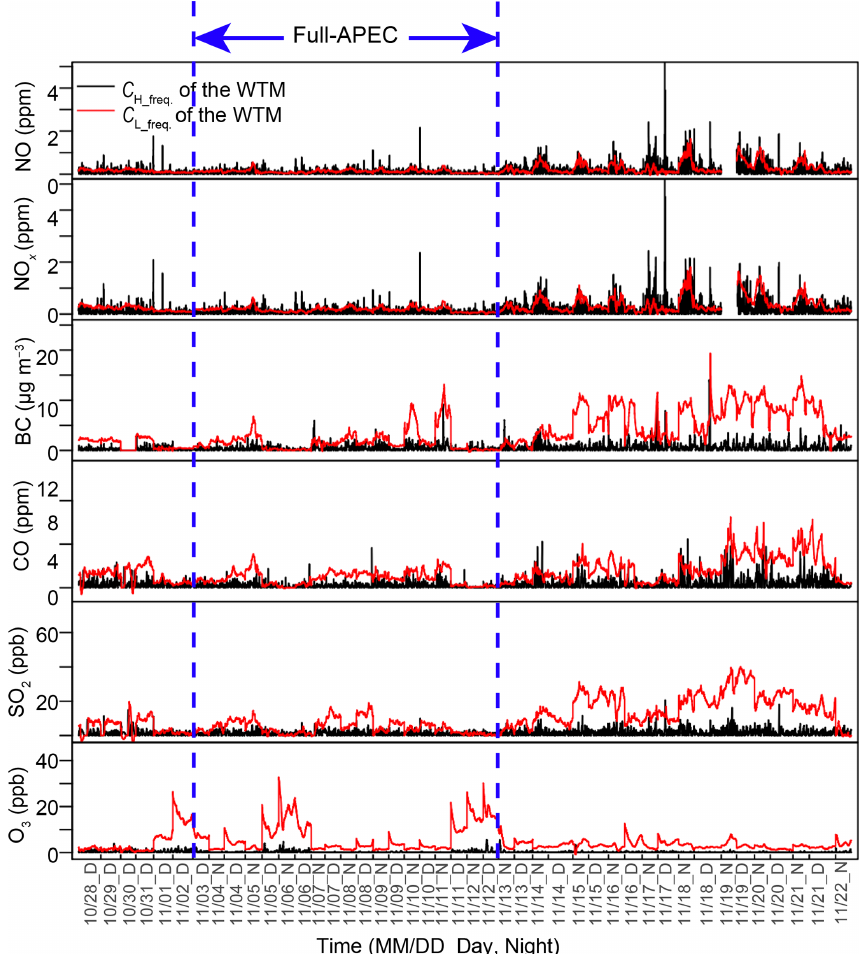
Figure 6. Time series of the decomposition results of the wavelet transform method (WTM) for NO, NO x , BC, CO, SO 2 , and O 3 (db6, eight levels; see text for details). The black lines represent the high-frequency components of the WTM, which should originate from immediate vehicle emissions. The red lines represent the low-frequency components of the WTM, which correspond to the atmospheric background plus accumulated on-road